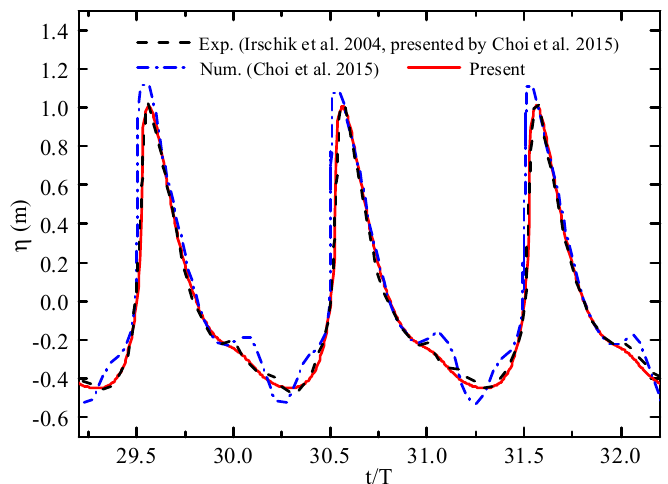
Figure 7. Comparison of free surface elevations at WG2 between the present result and the published data for the inclined cylinder ( ϕ = − 22.5 ◦ ).